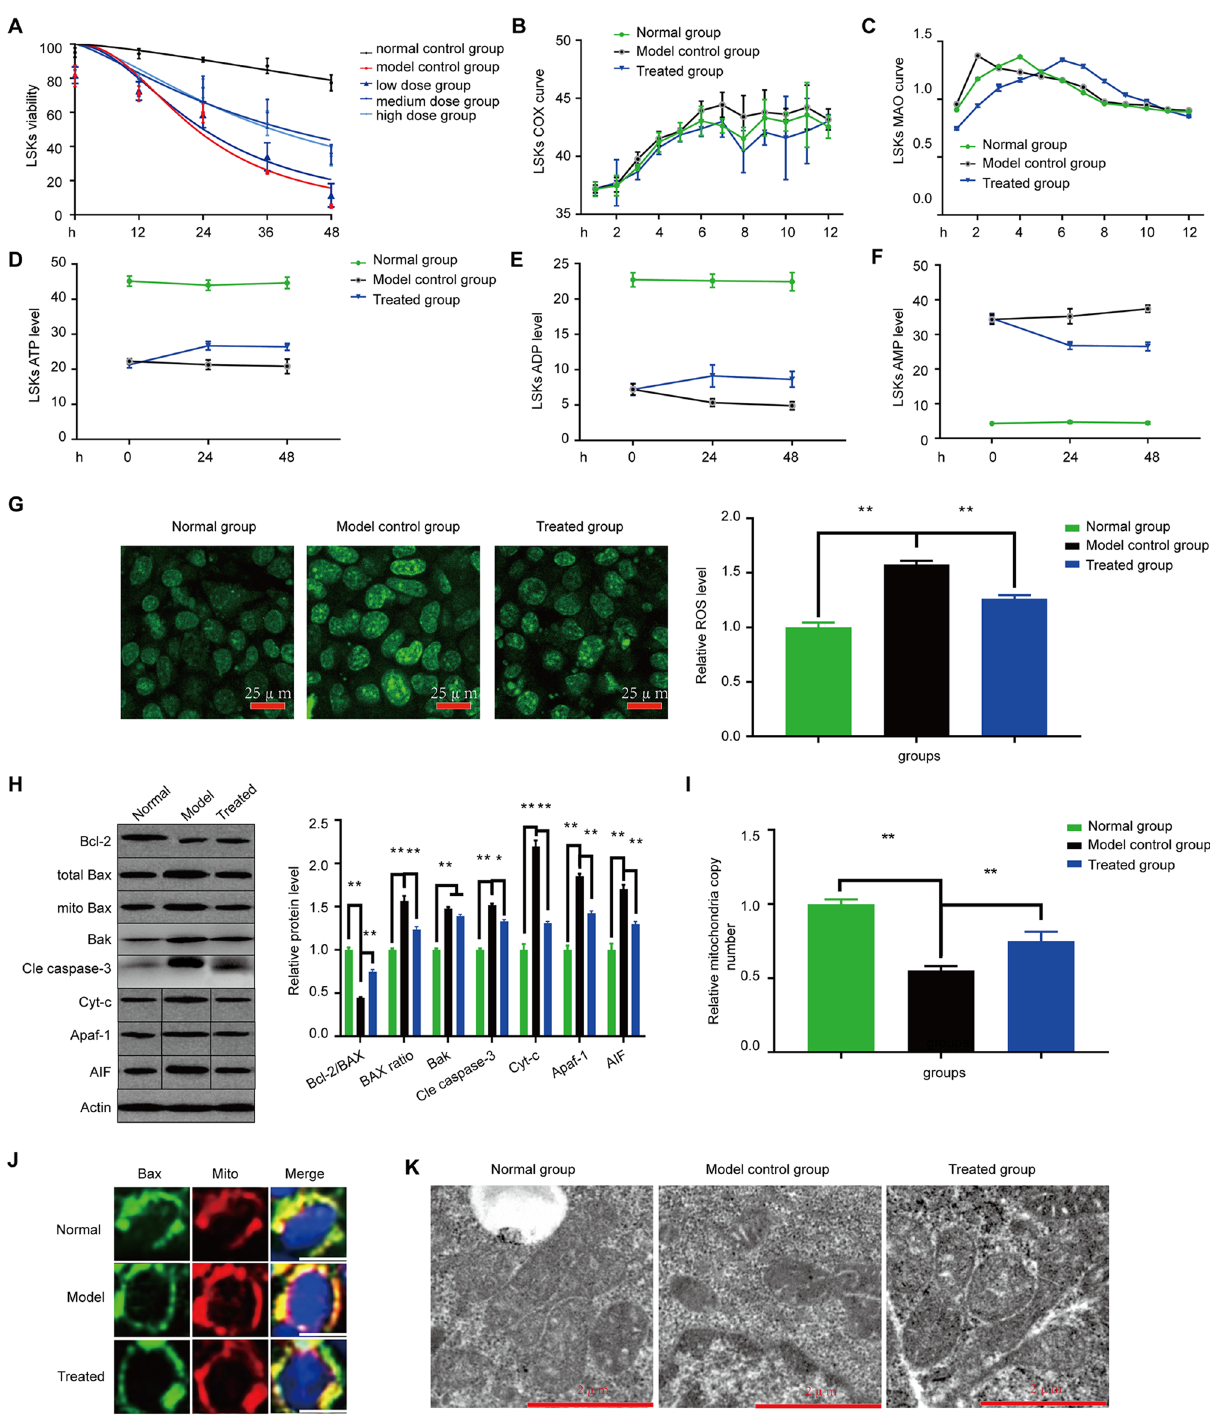
Figure 4. Effect of Rg1 on mitochondrial apoptosis of LSK cells in vitro. ( A ) The cell viability of LSK cells was detected by PrestoBlue Assay. ( B ) and ( C ) As markers of kinase activity in the outer membrane and inner membrane, respectively, MAO and COX levels were determined in LSK cells, and concentration–time curves of MAO/COX were constructed to determine the efficacy of Rg1. ( D – F ) The ATP/ADP/AMP levels in different groups. ( G ) Ros levels in different groups. ( H ) The protein test of Bax translocation-induced mitochondria. ( I ) Mitochondrial DNA copy number determined by real-time PCR. ( J ) The colocalization of Bax with mitochondria (yellow dots). ( K ) Mitochondrial structure was detected by electron microscopy. *P < 0.05 and **P < 0.01 compared with the model control